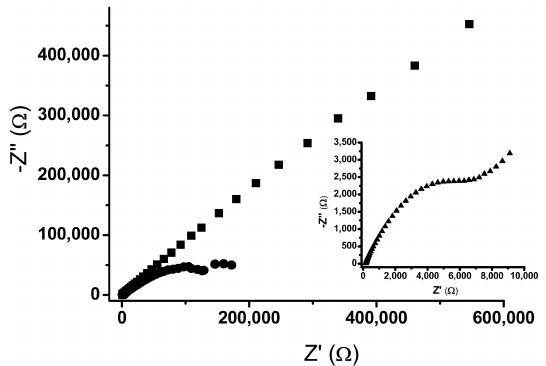
Figure 2. The Nyquist plots obtained for PdO@CPE ( (cid:4) ) and CPE ( ). Insert: Nyquist plot for TiO 2 @CPE ( (cid:78) ).